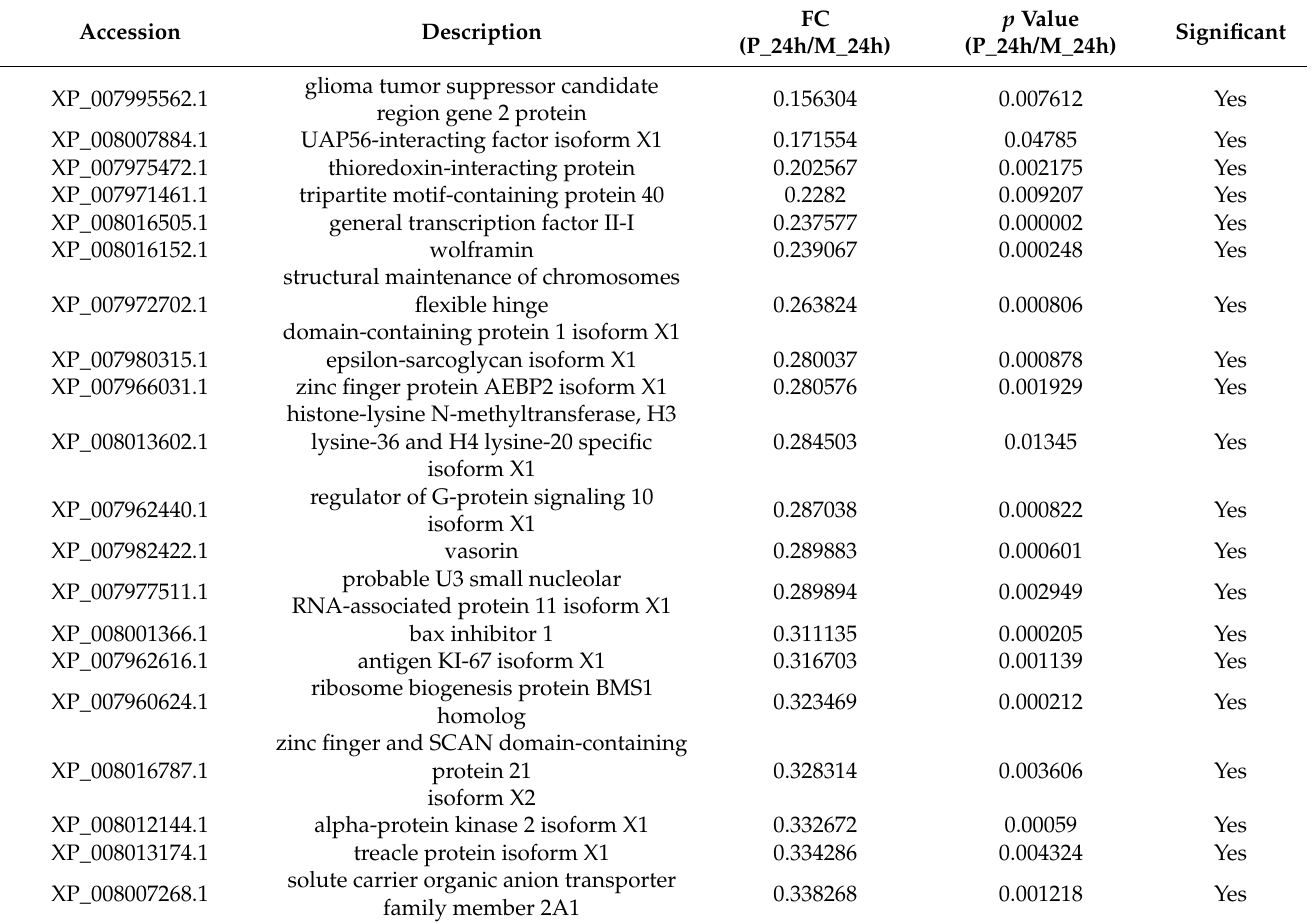
Table 3. Top 20 down-regulated